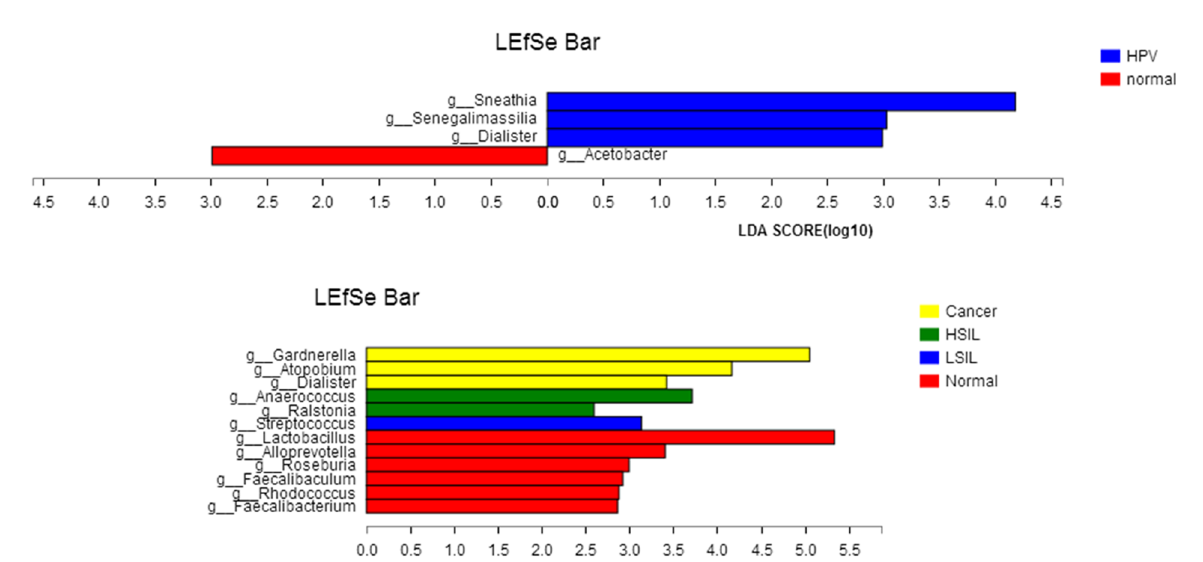
Figure 4 - Linear discriminate analysis effect size (LEfSe) was performed between different disease stages. (A) According to HPV infection, LEfSe was used to detect the difference in relative abundance of microbiota. (B) According to cervical intraepithelial neoplasia status , LEfSe was used to detect difference in microbiota relative abundance. Only taxa with LDA scores of >2 are